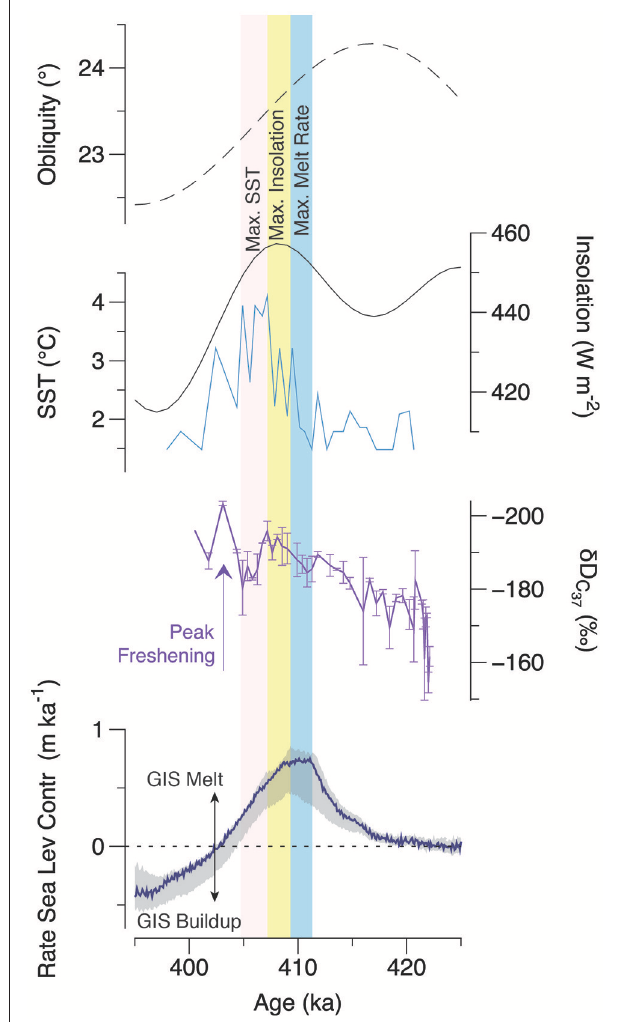
FIGURE 7 | Surface properties of the Nordic Seas and GIS meltwater. (Top to bottom) Insolation and obliquity curves ( Berger and Loutre, 1991), SST record from the Nordic Seas ( Kandiano et al., 2016), and modeled GIS demise as exemplified by rate of sea level (Robinson et al.,